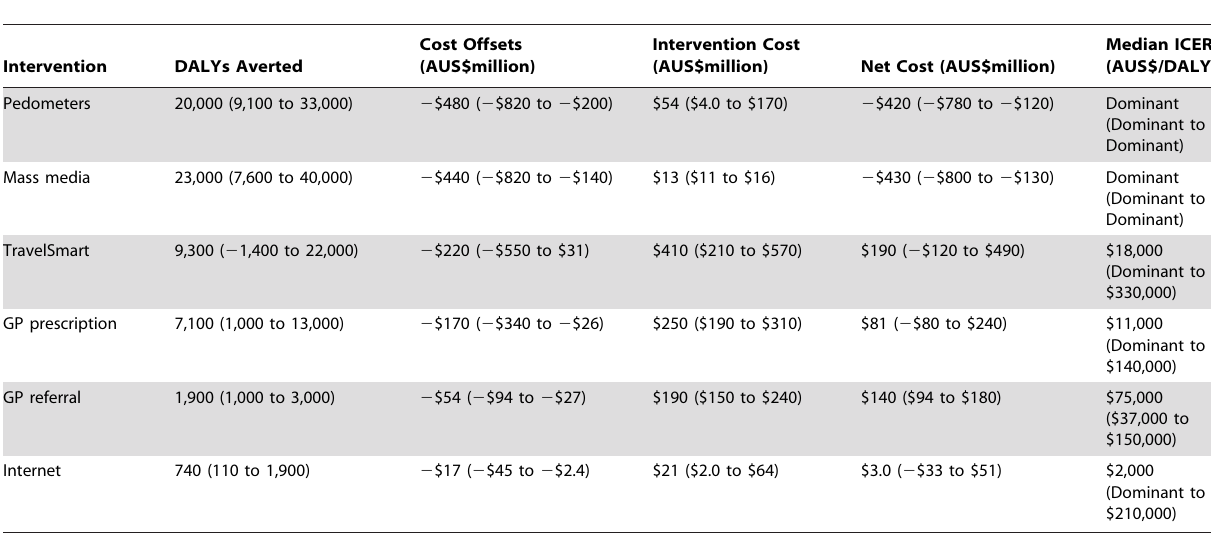
Table 3. Cost-effectiveness of physical activity interventions when compared with current practice.